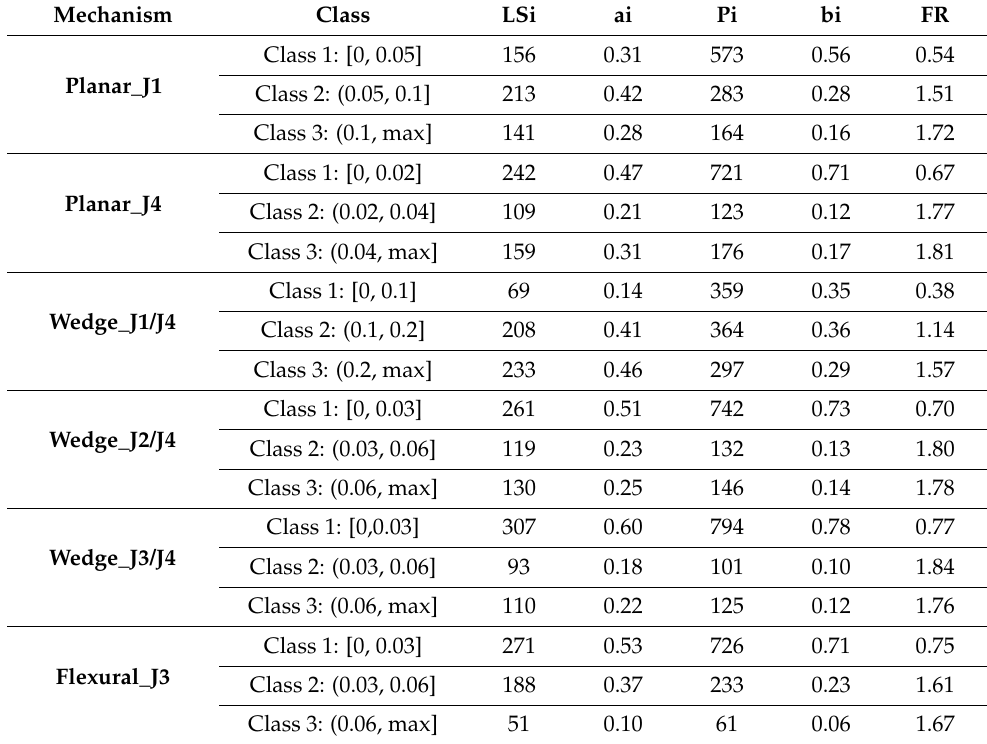
Table 4. The results of FR analysis of the discontinuity-related factors, including Planar_J1,